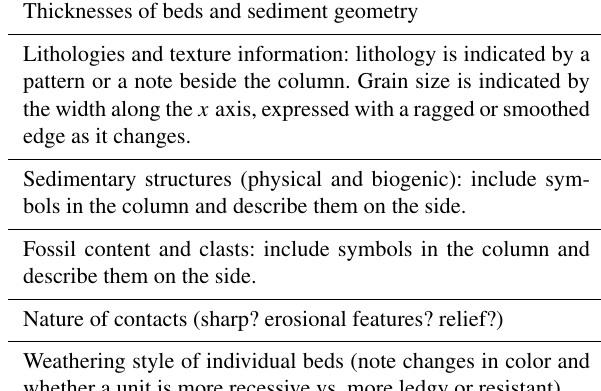
Table 1. Key features to include for drafting a stratigraphic column in the Grand Ledge